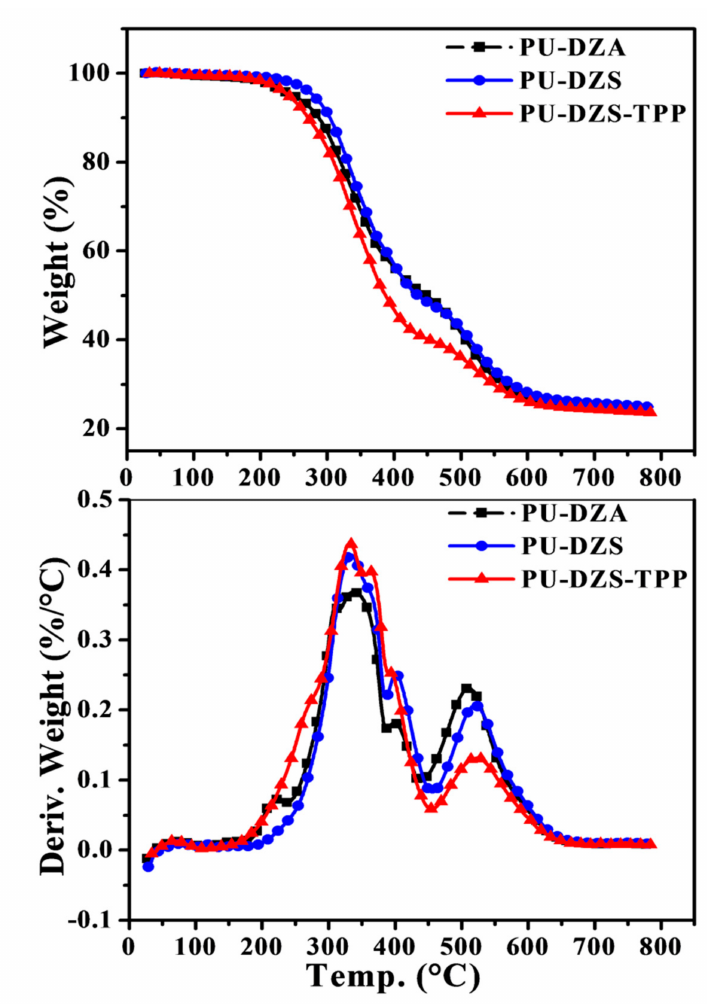
Figure 8. TG ( up ) and DTG ( bottom ) curves of PU-DZS, PU-DZA, and PU-DZS-TPP 25 samples at a heating rate of 10 ◦ C/min in N 2